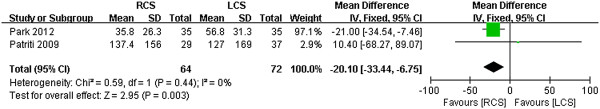
Meta-analysis of the EBLs shown as a forest plot between robotic-assisted colorectal surgery (RCS) and laparoscopic colorectal surgery (LCS). The mean differences with 95% CIs are shown.